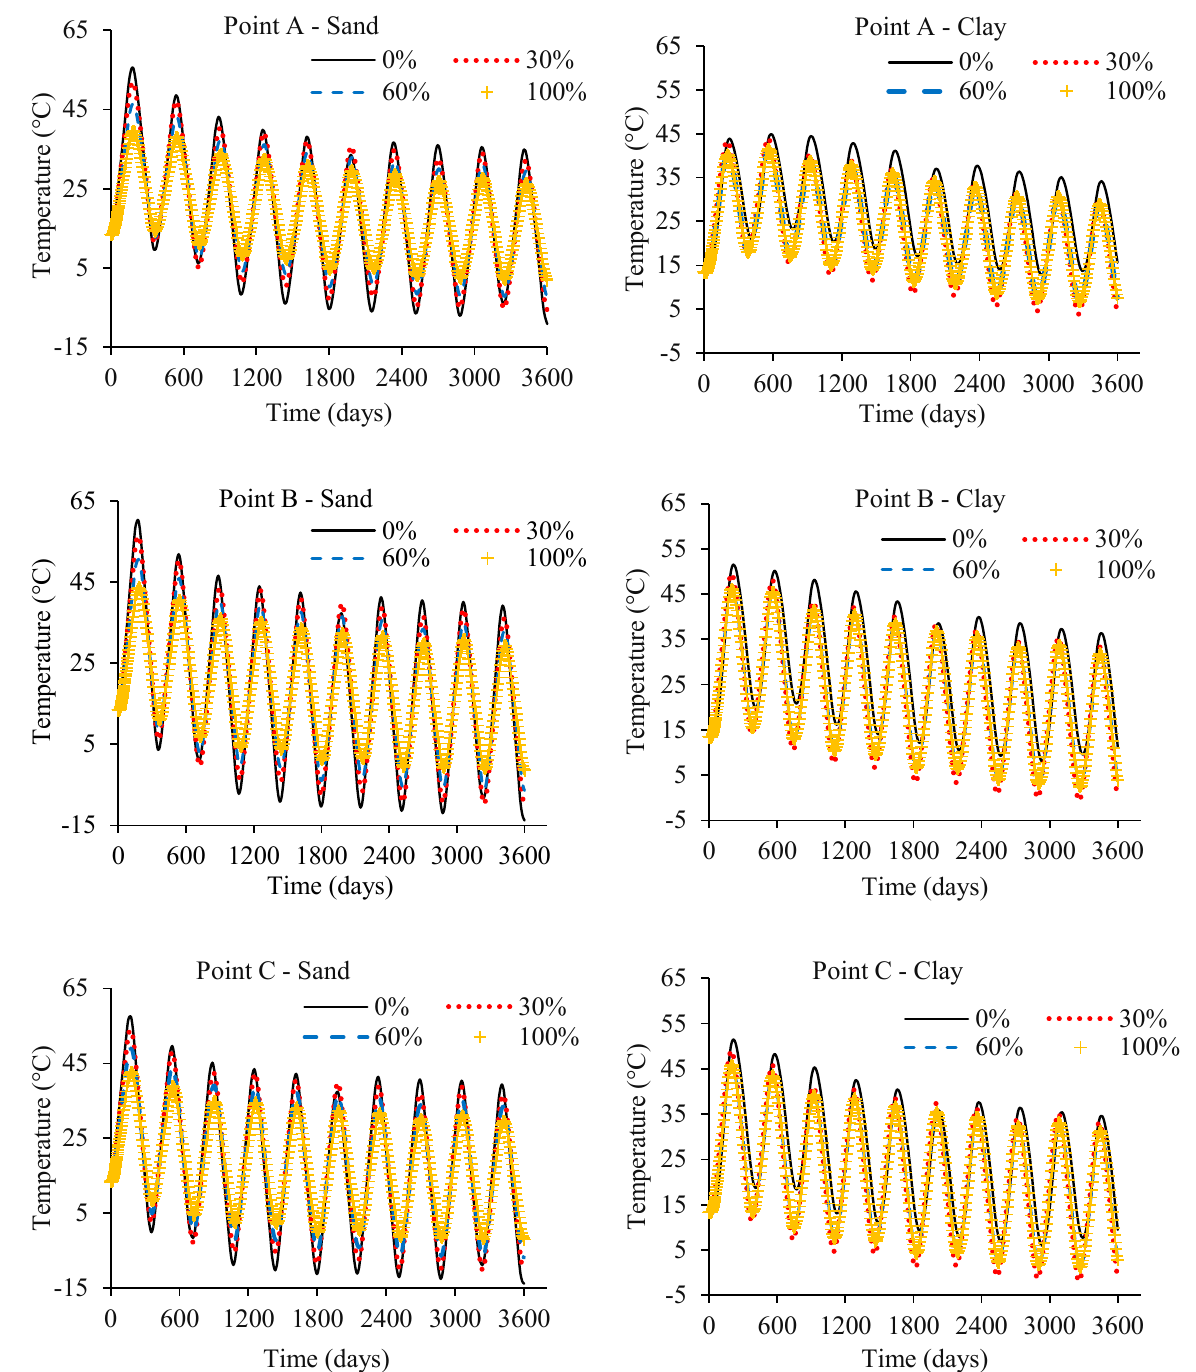
Figure 10. The results of temperature evolution with time at points A, B, and C for the cyclic heating and cooling of all GEPs in the group .